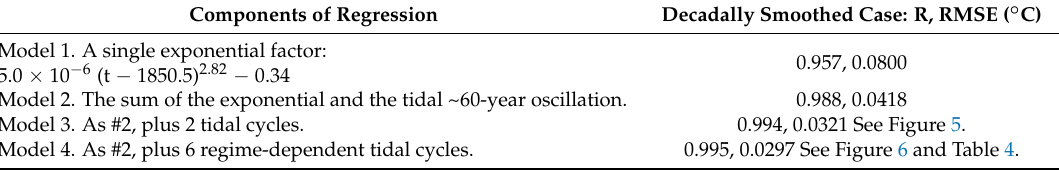
Table 5. Statistical results for succeeding models of simulating HadCRUT4 decadally smoothed GMST anomalies.